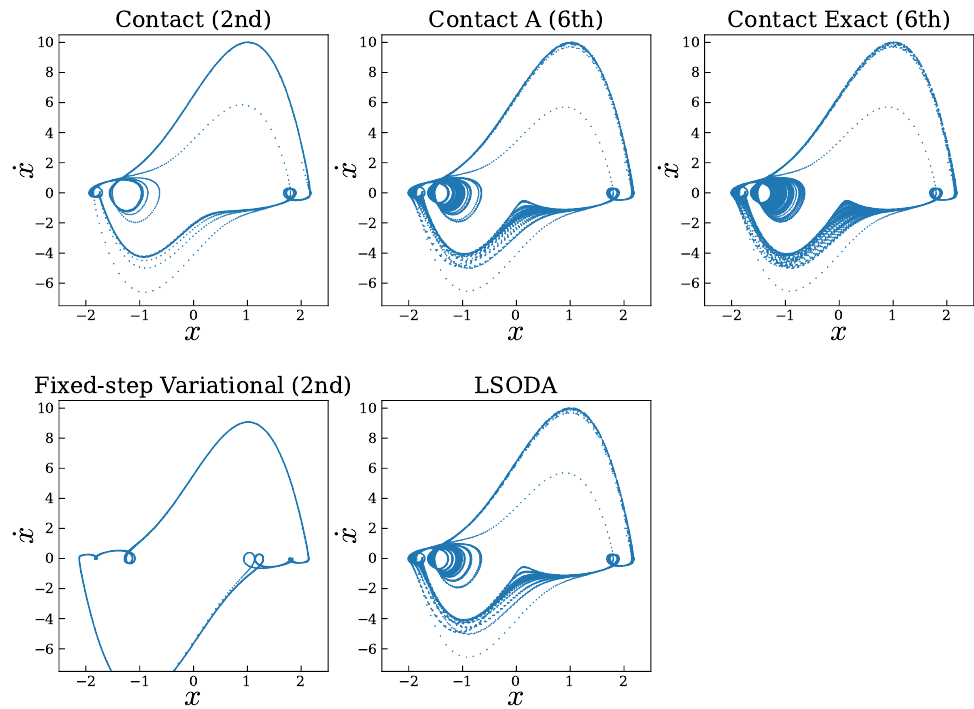
Figure 11. Numerical orbits of the forced van der Pol oscillator (75) with A = µ = 5, ω = 2.463 and ( x ) = ( 2,2 ) , with the reference contact integrators and 0 , ˙ x 0